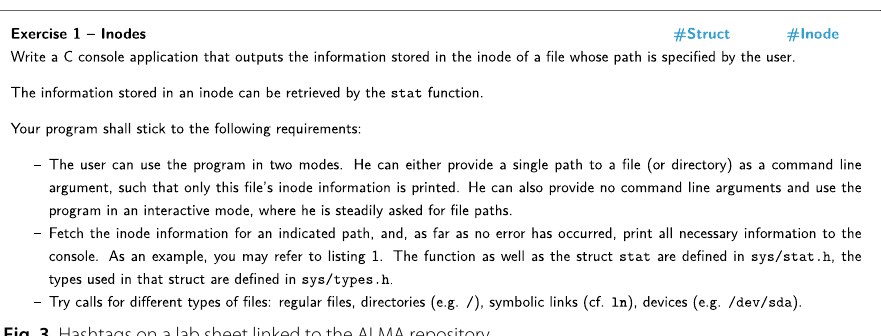
Fig. 3 Hashtags on a lab sheet linked to the ALMA